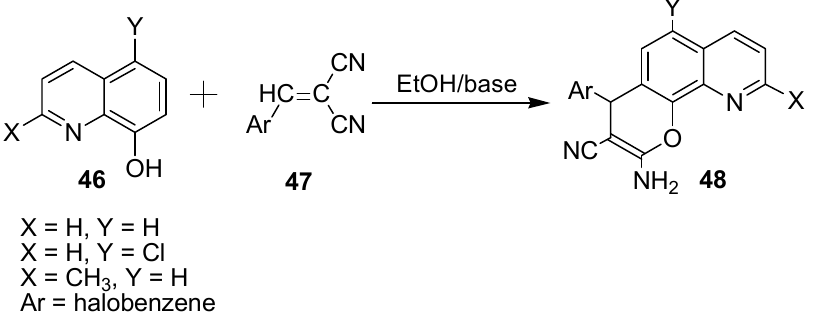
Scheme 12. Synthesis of new derivatives of halogenated 2-amino-4-aryl-4-pyrano[3,2- h ]quinolone-3-